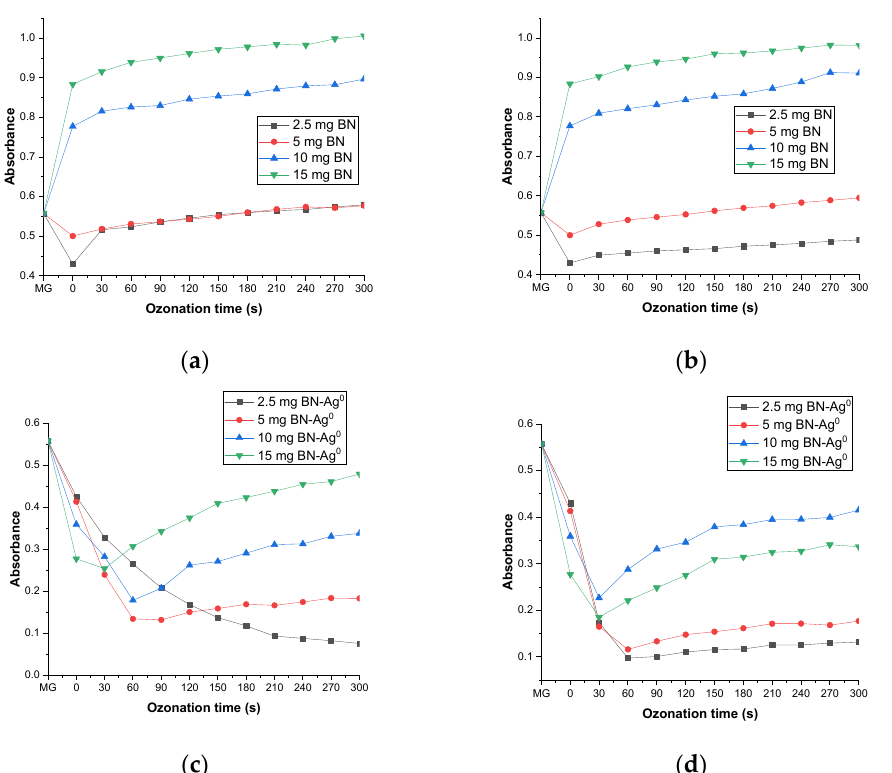
Figure 12. Catalytic ozonation of MG solution (5 × 10 − 5 M, initial absorbance 0.5572), using different amounts of BN (2.5, 5, 10 and 15 mg) and different doses of O 3 , 0.5 g · h − 1 ( a ) and 1 g · h − 1 ( b ); different amounts of BN-Ag 0 (2.5, 5, 10 and 15 mg) and different doses of O 3 : 0.5 g ∙ h − 1 ( c ) and 1 g ∙ h − 1 ( d ), 20 mL of dye solution, ozonation time (0–300 s).